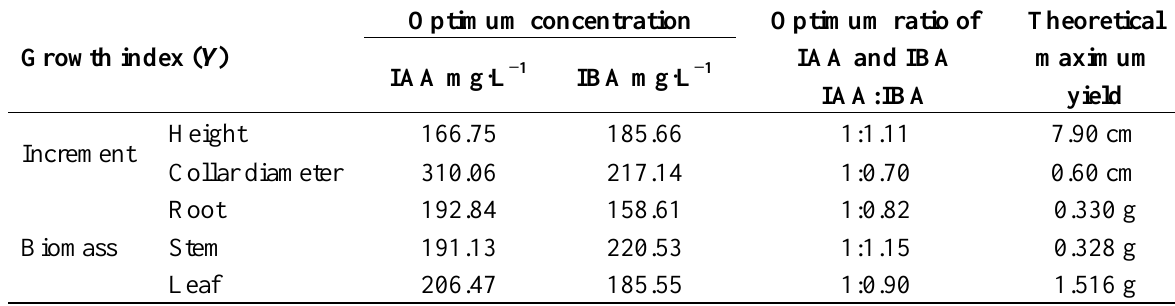
Table 3. Interaction effect analysis of growth index in response to IAA and